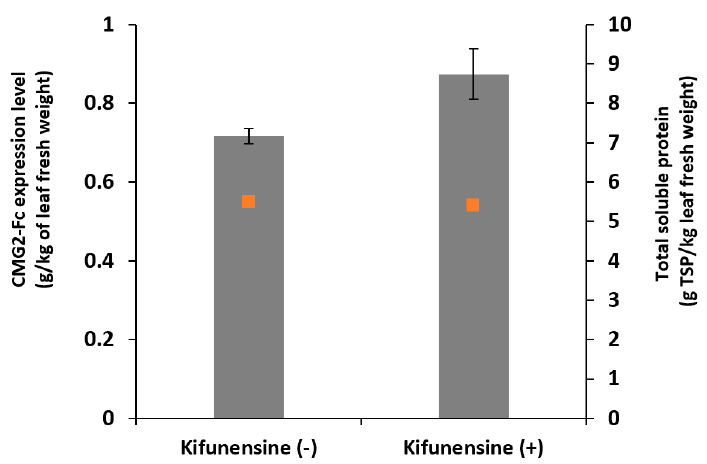
Figure 1. Expression levels of CMG2-Fc at day 6 post-infiltration as measured by ELISA (grey bars) and total soluble protein (TSP) in crude plant extract (orange dots). Kifunensine ( − ) stands for the control group without addition of kifunensine in the agrobacterium suspension; kifunensine (+) stands for the experimental group with 5.4 µM of kifunensine in the agrobacterium suspension. The CMG2-Fc levels are presented on the leaf fresh weight (FW) basis. Error bars represent standard deviations of duplicated ELISA measurements and duplicated Bradford measurements.